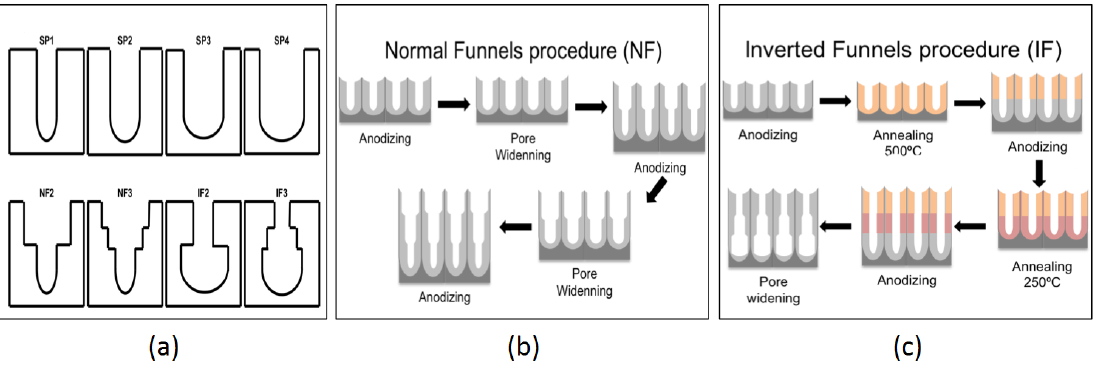
Figure 1. ( a ) Schematic illustration and labeling of the different pore geometries; ( b ) Schematics of the fabrication procedures for normal funnels; and, ( c ) inverted funnels.